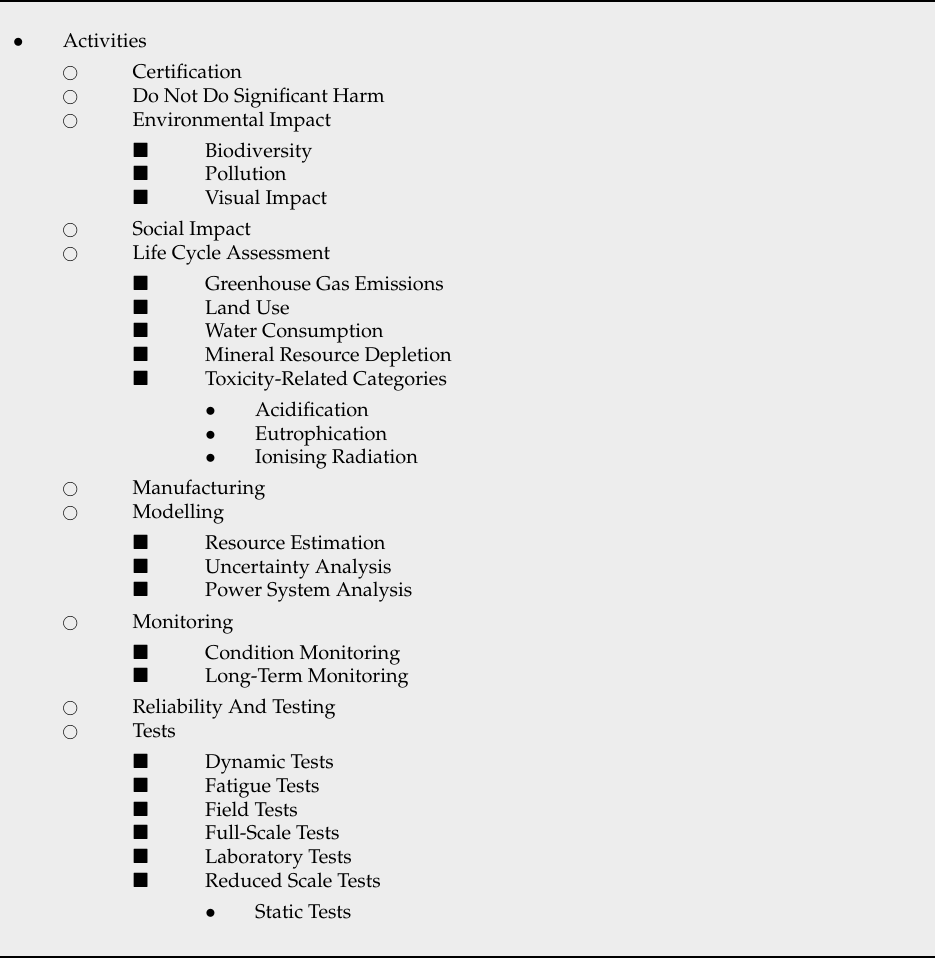
Table 18. Hierarchy for Activity-related